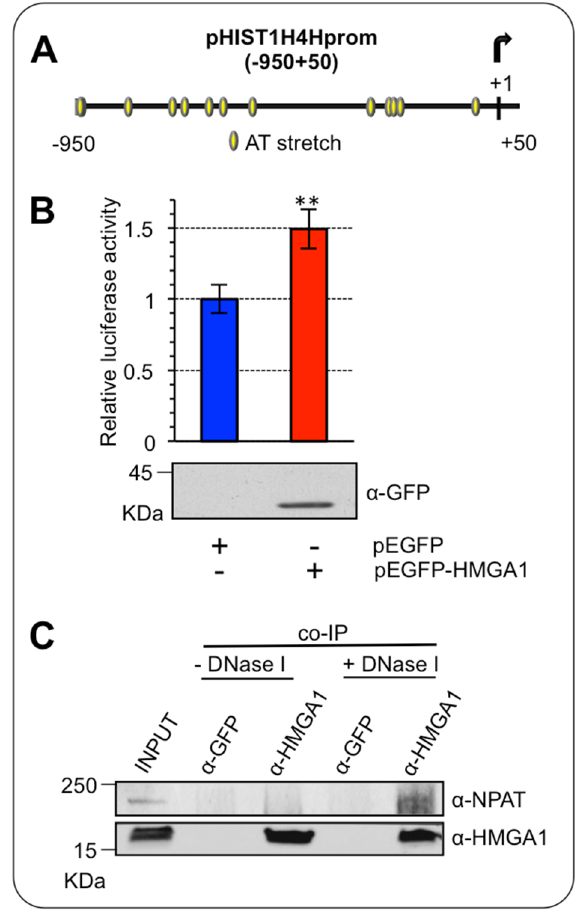
Figure 4. HMGA1 activates HIST1H4H/H4h promoter. ( A ) Schematic representation of the putative HMGA1-binding sites (from − 950 to +50) on the promoter region of HIST1H4H. ( B ) HEK293T cells were transiently co-transfected with the luciferase reporter plasmid pGL4.11-H4H and the expression plasmid pEGFP-HMGA1 or pEGFP empty vector as control. pRL-CMV Renilla luciferase expression vector was included to normalize for transfection efficiency. Values are reported as relative luciferase activity compared to cells transfected with the pEGFP empty vector. The data are represented as means. Standard deviations are shown ( n = 3). Statistical significance was assessed with Student’s t test (**: p ≤ 0.01). At the bottom is shown the western blot of total cell lysates to check for GFP-HMGA1 expression, using an α -GFP antibody. ( C ) Co-immunoprecipitation (co-IP) of HMGA1 and NPAT. The experiment was performed with either the negative control ( α -GFP) or the α -HMGA1 antibody on MDA-MB-231 cell lysates in presence or absence of DNase I. The input and the immunoprecipitated proteins were subjected to western blot analysis with the α -HMGA1 and the α -NPAT antibodies.